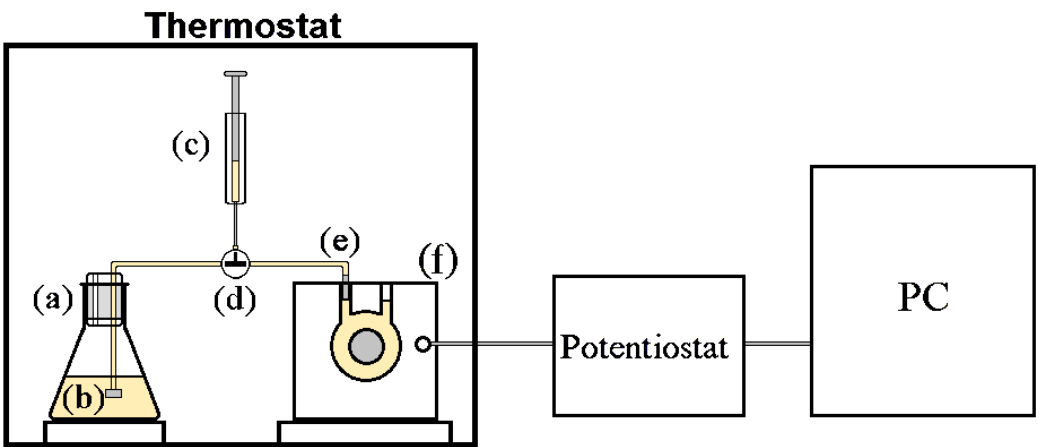
Figure 1. Experimental apparatus: ( a ) flask containing glucose and yeast in glycine solution; ( b ) first small filter; ( c ) graduated syringe; ( d ) turning tap; ( e ) second small filter; ( f ) catalytic fuel cell.